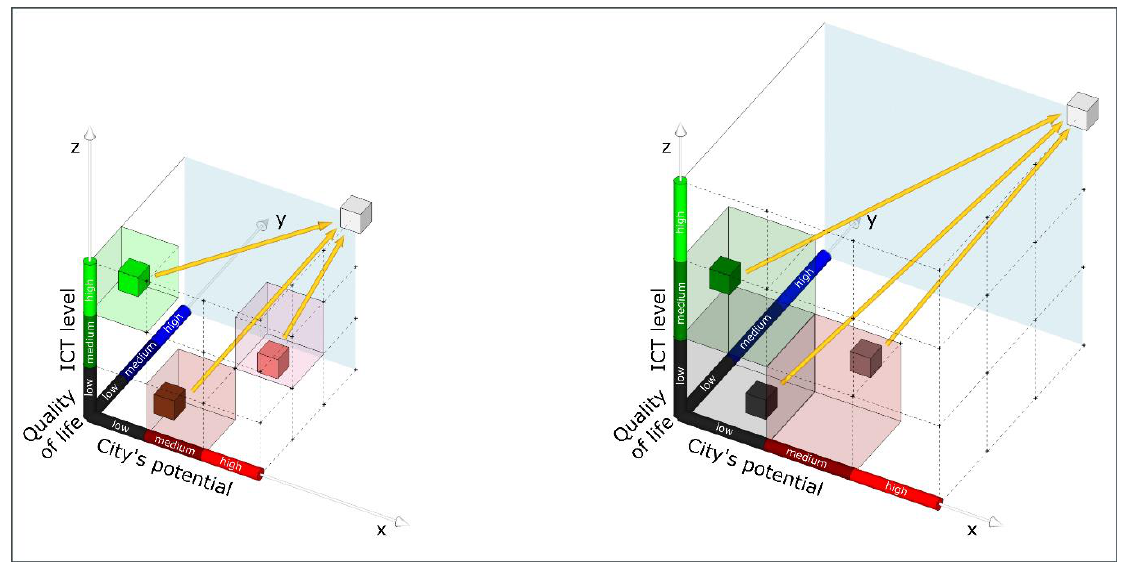
Figure 5. Smart city transformation—the concept of an expanding cube.